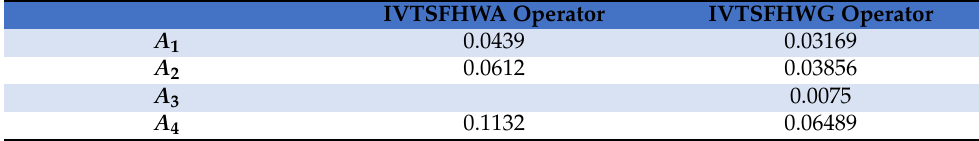
Table 3. Score values of IVTSFHWA and IVTSFHWG